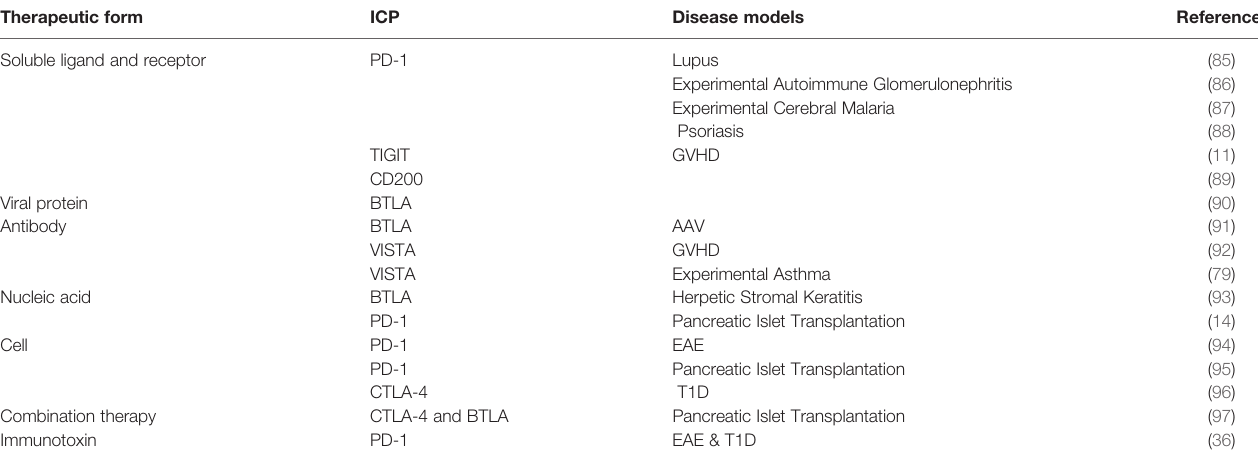
TABLE 3 | Experimental therapeutics to enhance ICPs. Therapeutic